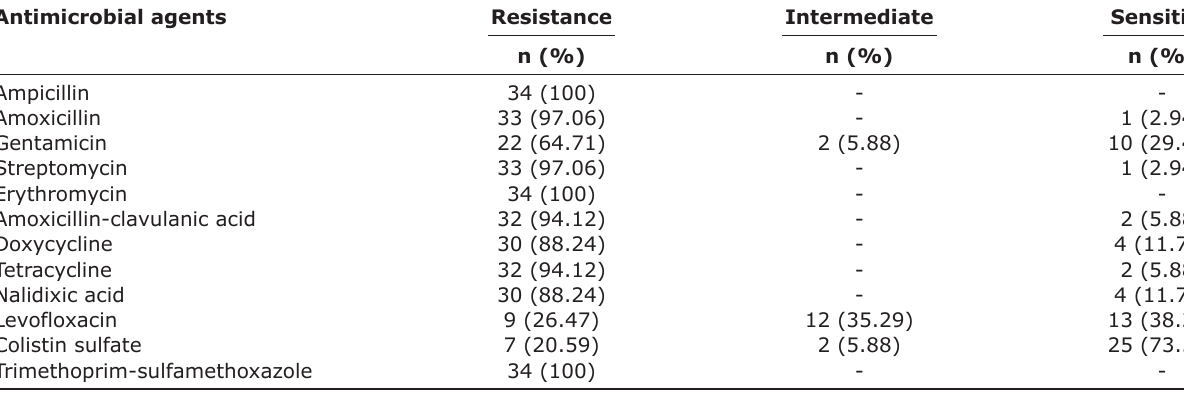
Table-3: Antibiotic resistance pattern of isolated E. coli . Antimicrobial